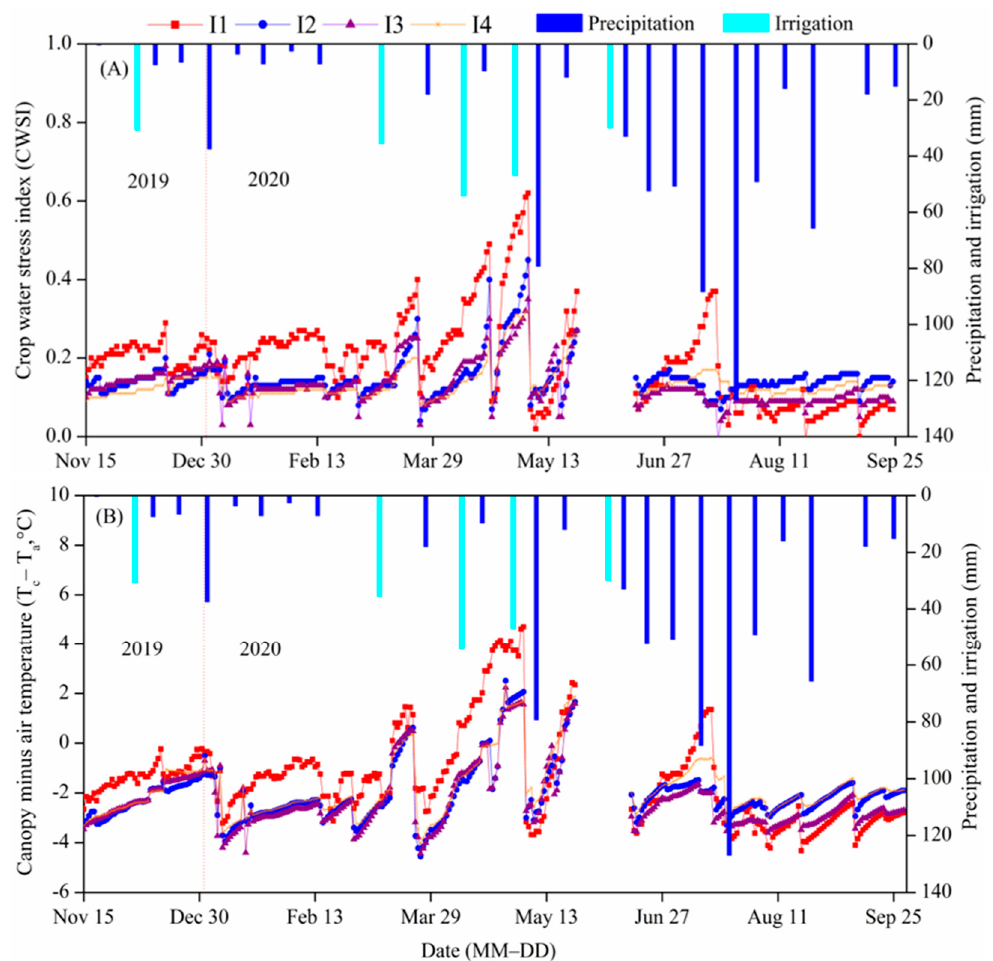
Figure 6. Dynamics of ( A ) crop water stress index (CWSI) and ( B ) canopy minus air temperature (T c − T a , °C) in a winter wheat–summer maize cropping system in 2019–2020 growing season. Precipitation is presented as ten-day cumulative values. Irrigation was average values among I1, I2, I3, and I4 treatments.